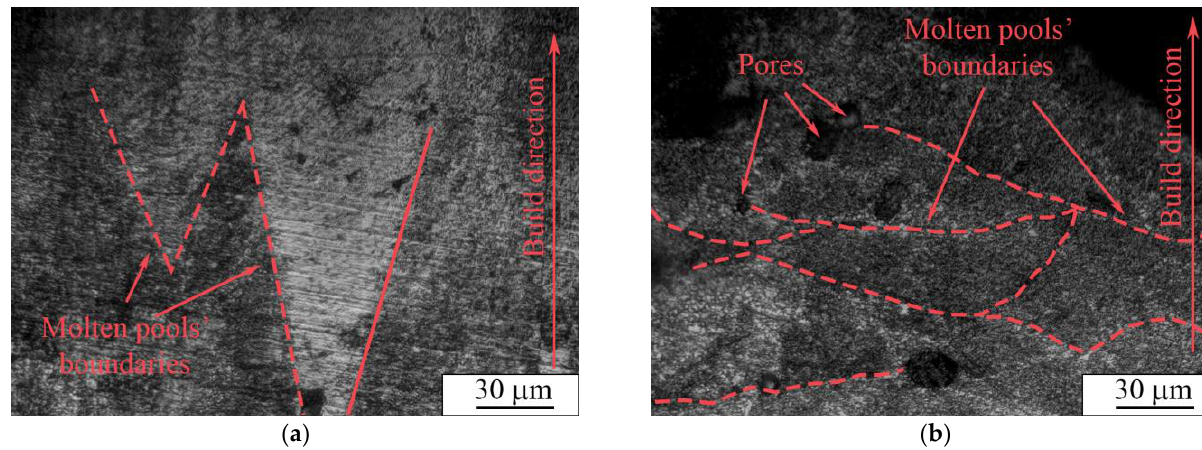
Figure 12. Optical images of ( a ) dense and ( b ) porous samples’ transverse sections.